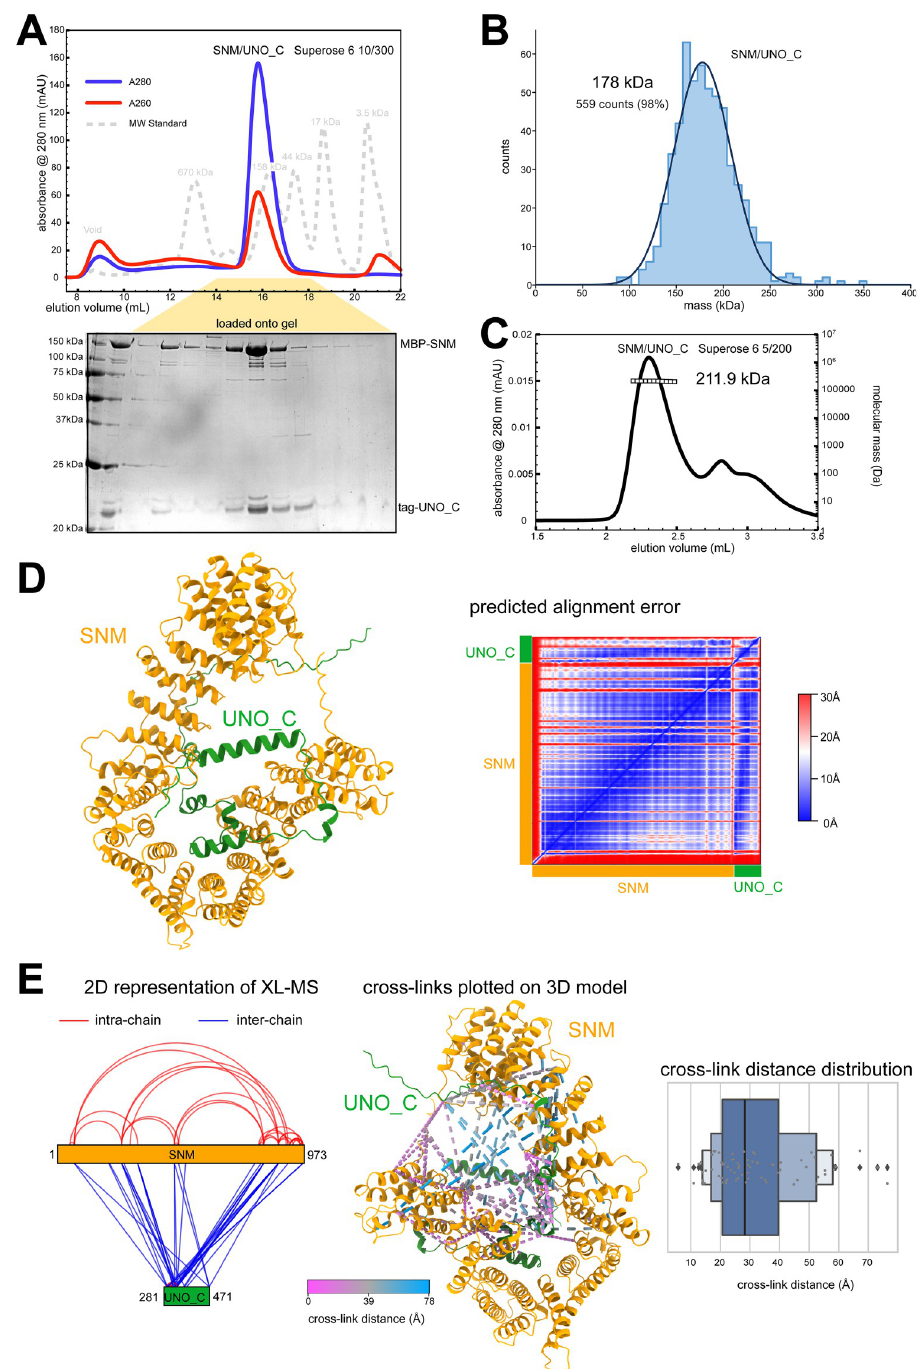
Fig 3. SNM and UNO_C form a stable heterodimeric complex. ( A ) SNM and UNO_C, with N-terminally fused maltose-binding protein (MBP) and twin Strep-II affinity tag (Stag), respectively, form a stable SU_C complex. Size exclusion chromatography profile from the final purification step and Coomassie-stained gel for analysis of the indicated peak are shown. ( B ) Mass photometry analysis of SU_C. The indicated molecular mass was determined by a Gaussian fit of the distribution of counts calibrated against a molecular mass standard. ( C ) SEC-MALS analysis of SU_C, revealing the indicated molecular mass. ( D ) AF2 model of SU_C with predicted alignment plot on the right. Regions associated with high (30 Å ) and low (0 Å ) error as predicted by the algorithm are shown in red and blue, respectively. ( E ) Analysis of SU_C by cross-linking mass spectrometry (XL-MS). The observed cross-links (with false discovery rate < 1%) were plotted onto 2D representations of SNM and UNO_C. Moreover, cross-links were